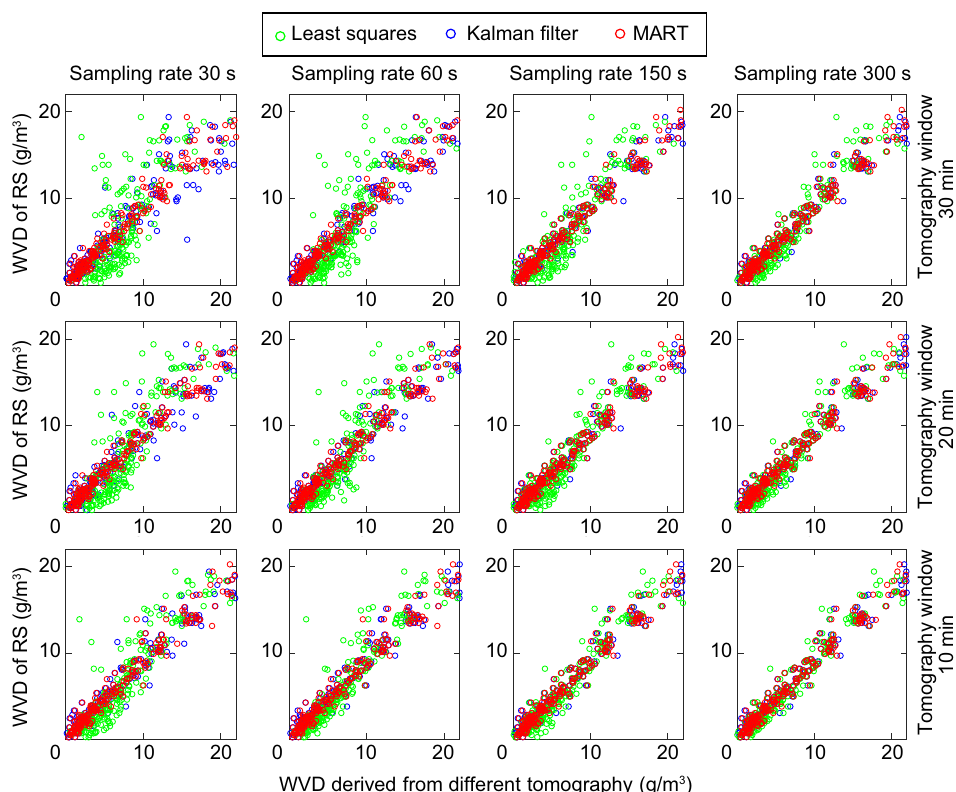
Fig. 7 Correlation of the WVD reconstructed with three tomographic methods and those derived from the radiosonde data in these 12